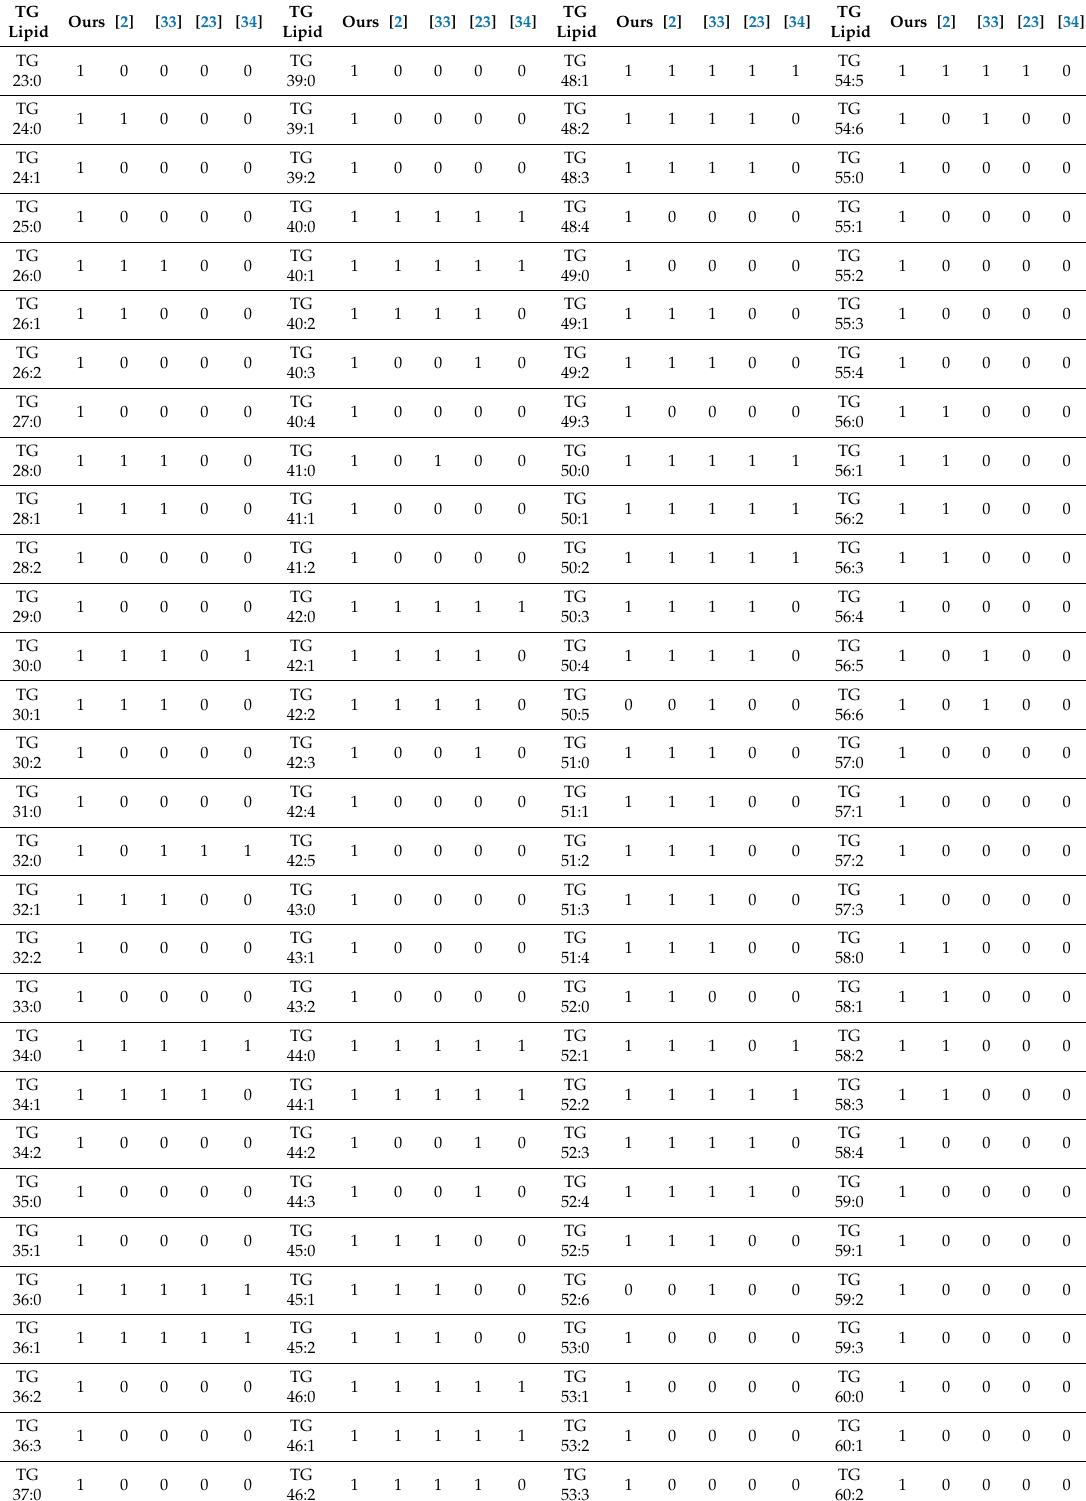
Table 3. Listoftriacylglycerol(TG)compositionspreviouslyreportedinthepublishedliterature[2,23,33,34]. A total of 65 novel sum compositions have been reported. Only two lipid compositions, namely TG 50:5 and 52:6, were not detected in our